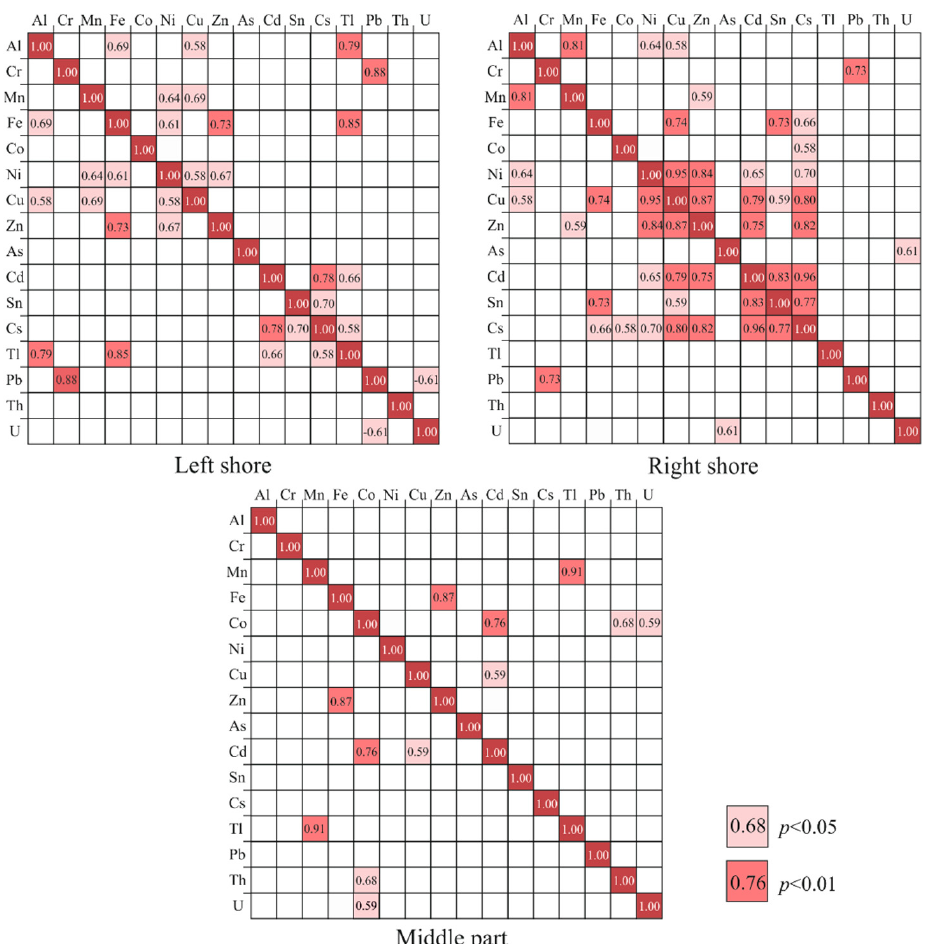
Figure 4. Statistically significant correlations between concentrations of trace elements in the water of the Angara River source.